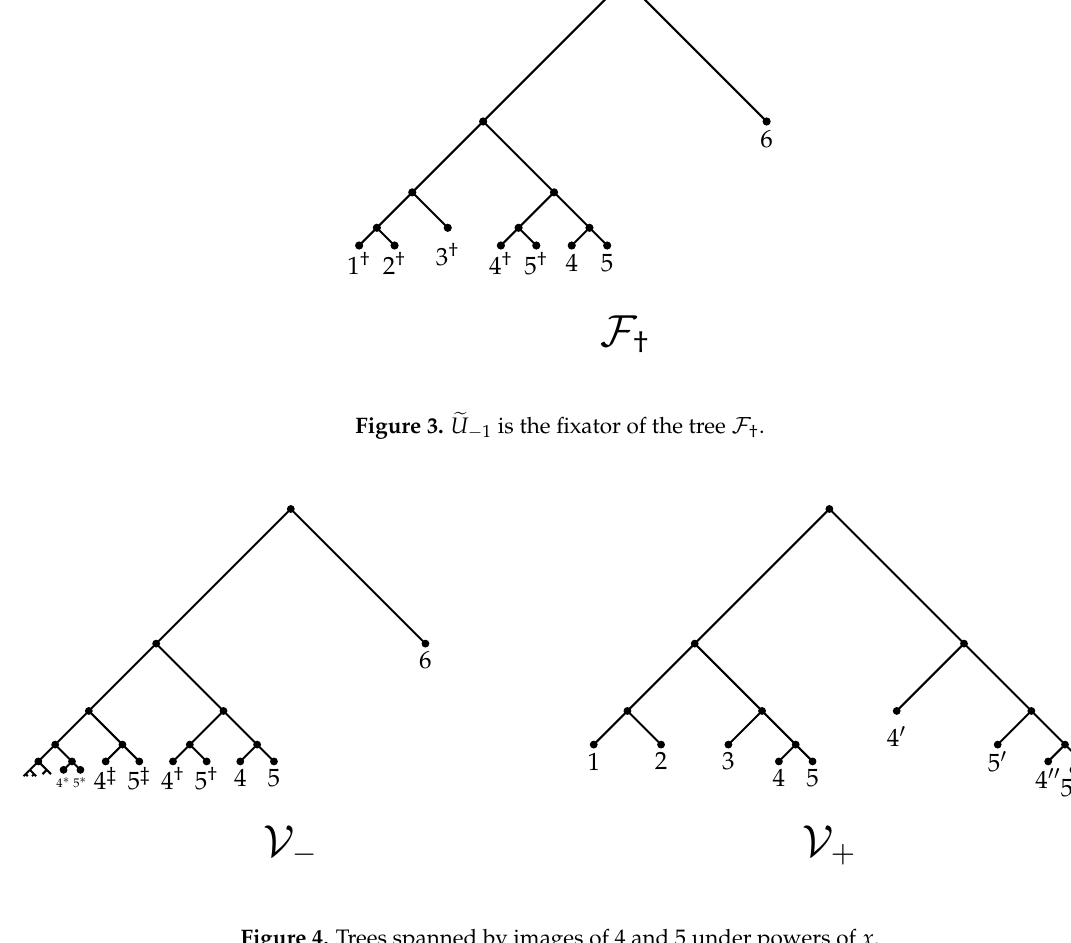
Figure 4. Trees spanned by images of 4 and 5 under powers of x